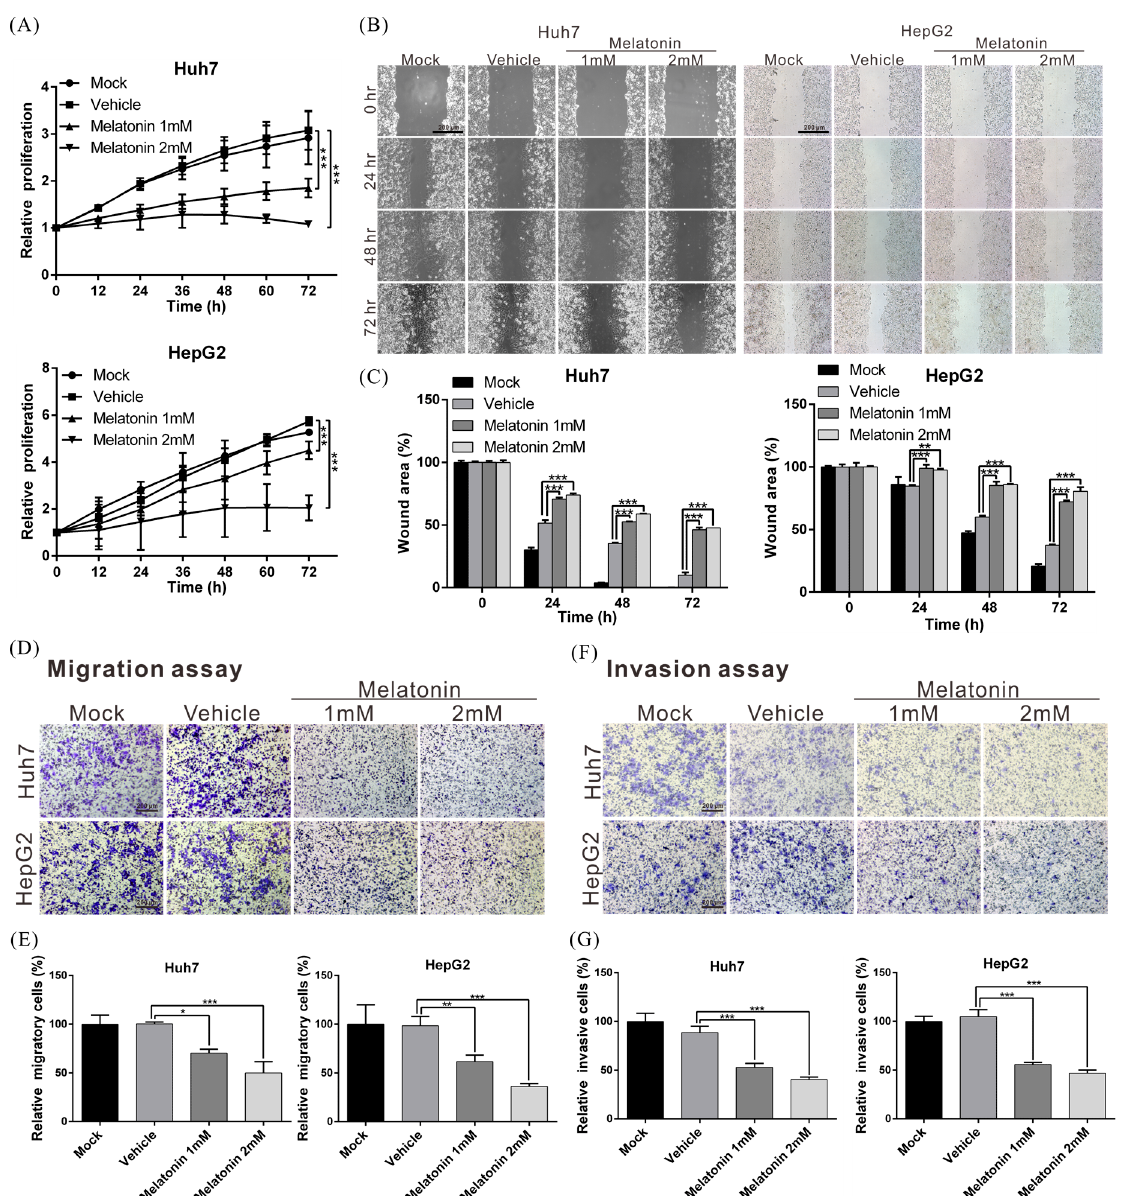
Figure 1. Melatonin suppresses HCC-cell proliferation, migration and invasion capacity in vitro. ( A ) Huh7 and HepG2 cells were treated with/without melatonin. Cell proliferative capacities were examined using an xCELLigence real-time cell analyzer. Mock: cells treated with Dulbecco’s modified Eagle’s medium. Vehicle: cells treated with dimethyl sulfoxide. ( B ) The effect of melatonin on the wound-healing ability of Huh7 and HepG2 cells was examined, and the results were quantified ( C ). Magnification: 100×. Scale bar = 200 μ m. ( D , F ) Transwell assays were performed to investigate the migration and invasion capacities of Huh7 and HepG2 cells treated with/without melatonin, and the results were quantified ( E – G ). All data are expressed as means ± SD of three independent experiments; * p < 0.05, ** p < 0.01, *** p < 0.001. Magnification: 100×. Scale bar = 200 μ m.